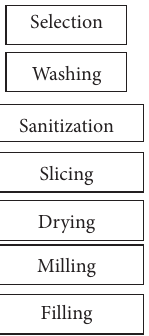
Figure 1: Flowchart of the dehydration process of the tomato.